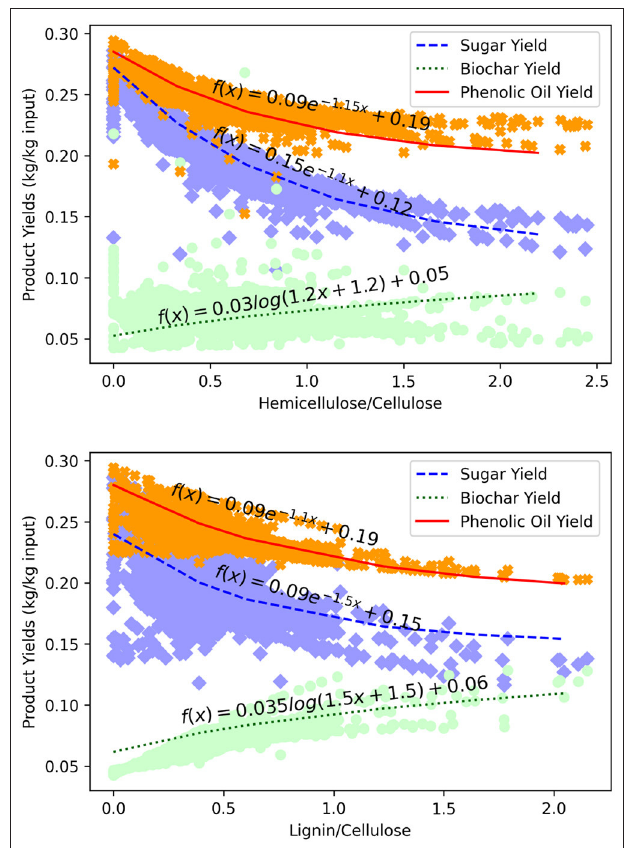
FIGURE 5 | Sugar, phenolic oil, and biochar autothermal pyrolysis product yield trends vs. hemicellulose/cellulose ratios (Top) and lignin/cellulose ratios (Bottom) .